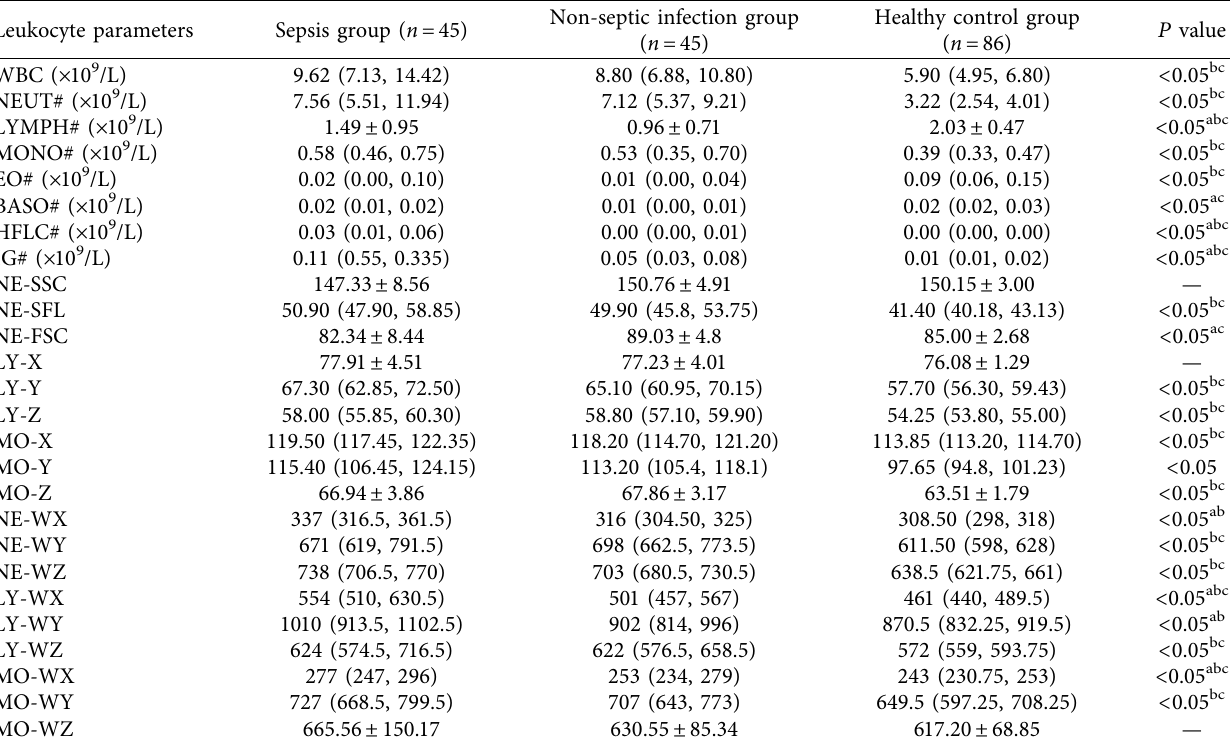
Table 3: Leukocyte parameter test results of sepsis group, nonseptic infection group, and healthy physical examination group. Leukocyte